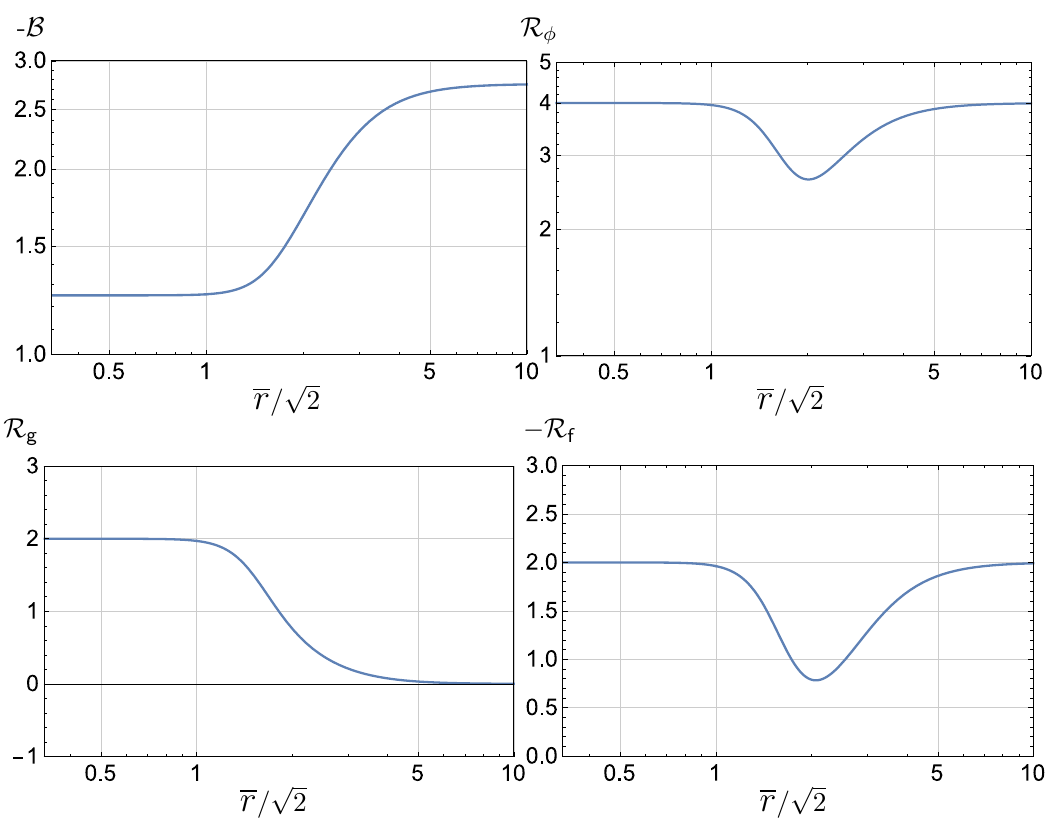
Figure 22. Radial pro(cid:12)le of B and local scaling of e (cid:30) , e f and e g as a function of the